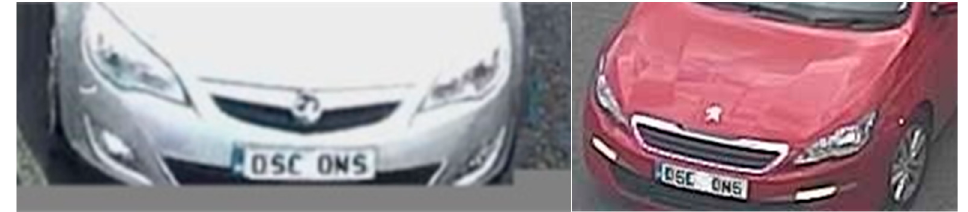
Figure 8. Modified examples of disclosive number plates captured on traffic cameras.